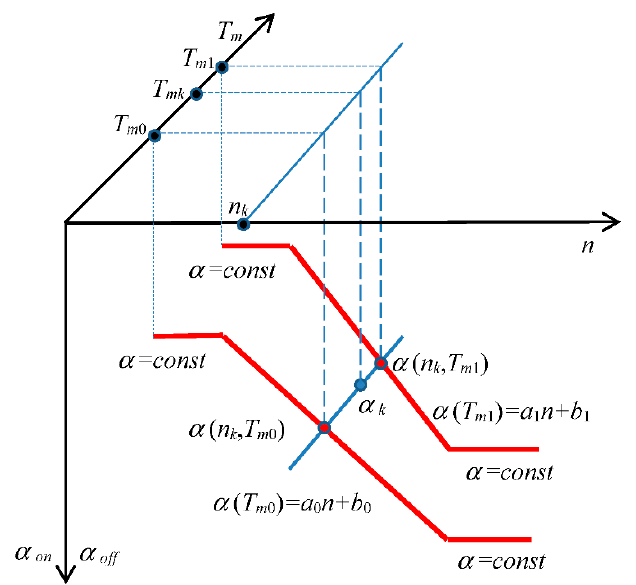
Figure 9. Method of calculation of the values of commutation angles in the field programmable gate array (FPGA) device.